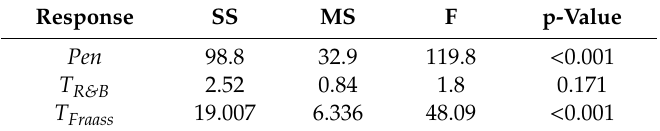
Table 5. Evaluation of significant influence (ANOVA) of the SAA factor on Pen , T R&B , and T Fraass